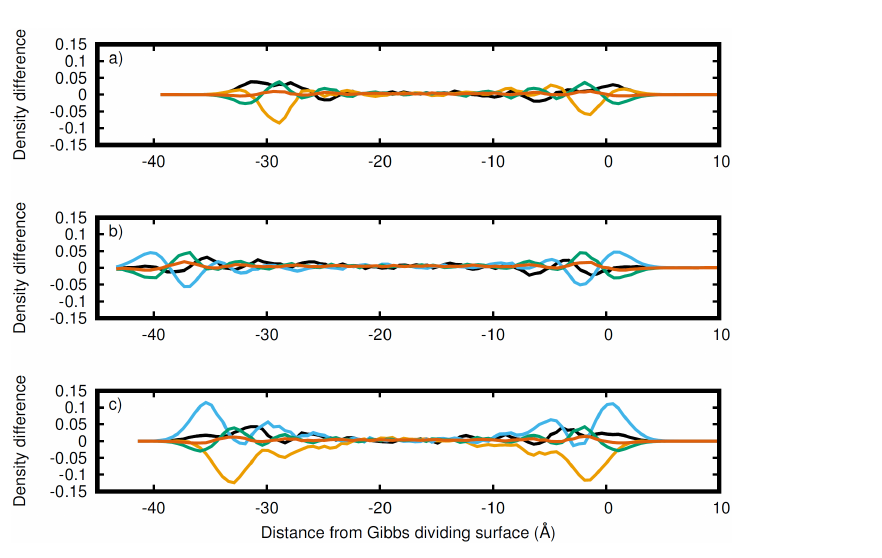
Figure 4 Atomic density differences from the total density profile in the dimension perpendicular to the Gibbs dividing surface. Li (black), Na (orange), K (blue), C (green), and O (red) for the (A) LiNaCO 3 , (B) LiKCO 3 , and (C) LiNaKCO 3 systems are shown. These are the profiles in Fig. 2 with the whole system profiles in Fig. 1 subtracted. These plots emphasize the contributions of each element to the total density profile. For each system, the right Gibbs dividing surface is positioned at 0